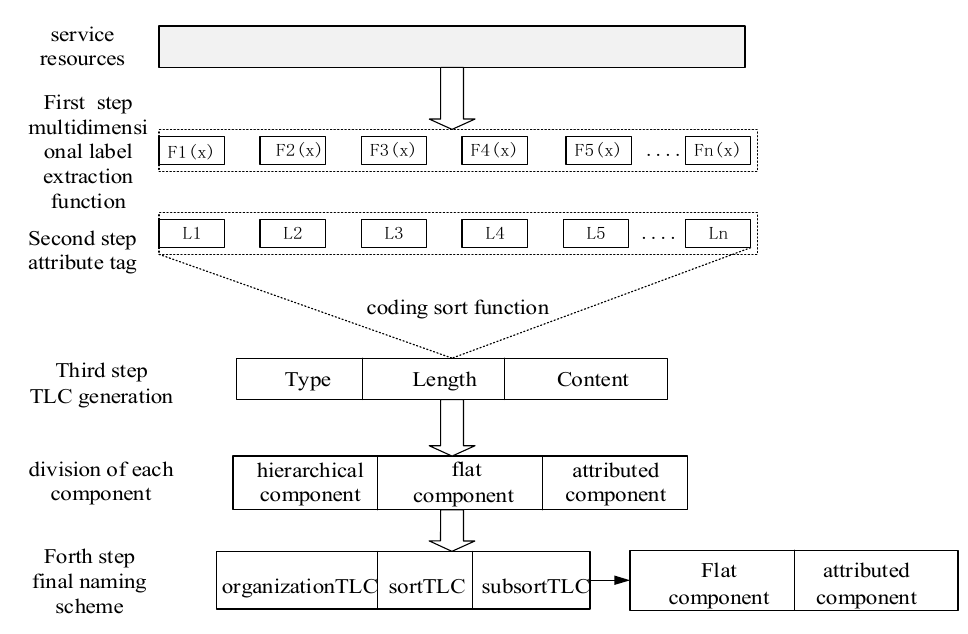
Figure 1. The overall design of the naming scheme.